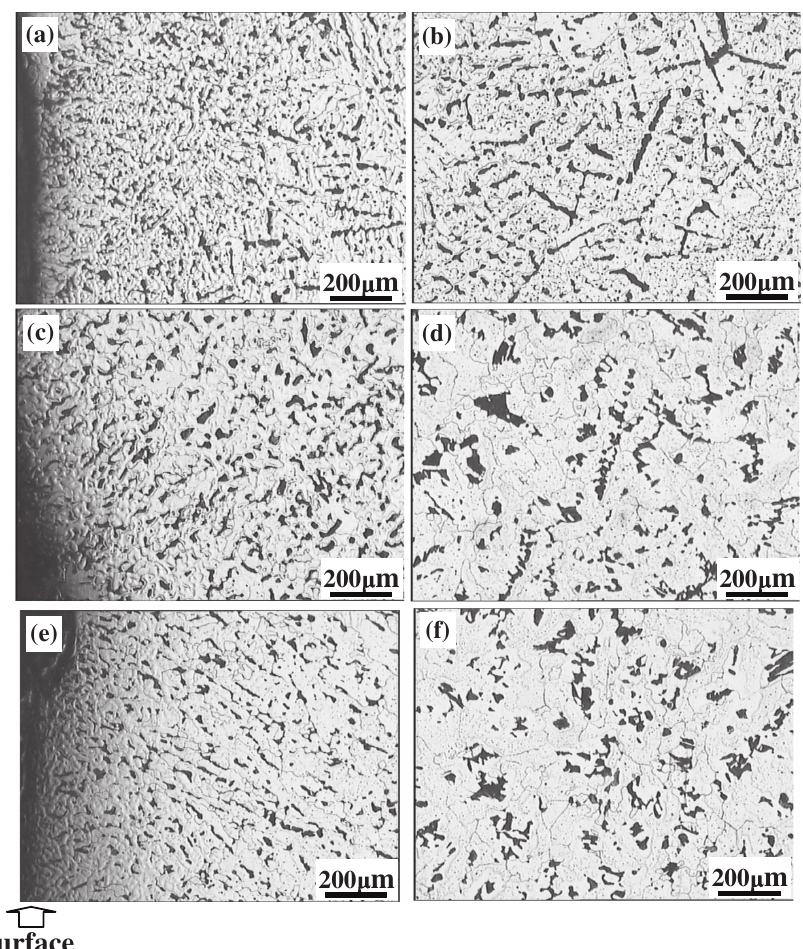
Figure 4: OM photos of the cross sec- tions of as-cast sample 1: near the sur- face (a) and at the center (b) with the thickness of about 2mm; near the sur- face (c) and at the center (d) with the thickness of about 13mm, and near the surface (e) and at the center (f) with the thickness of about